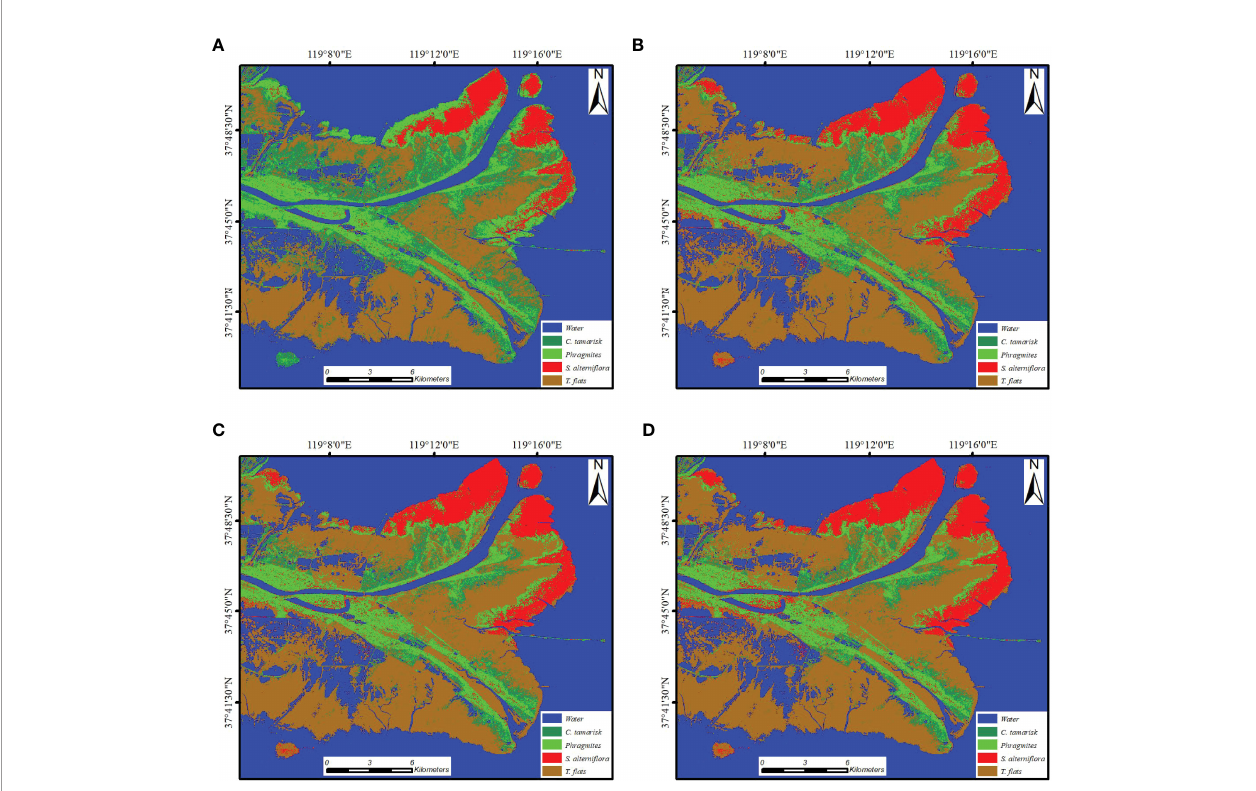
FIGURE 11 | Classi fi cation results of the Yellow River Delta wetlands in 2018. (A) is the classi fi cation results with no coherence; (B) is the classi fi cation results with only introducing VH coherence; (C) is the classi fi cation results with only introducing VV coherence; (D) is the classi fi cation results with introducing both VH and VV coherence.